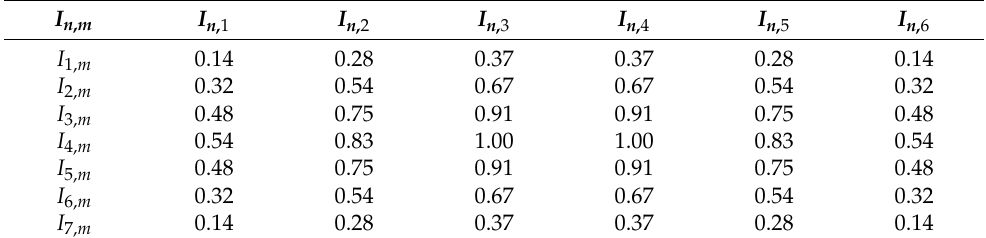
Table 2. Distribution of raised cosine amplitude proposed for the 7 × 6 planar array considering a value of a = 0.14 and a SLL PEAK = − 20